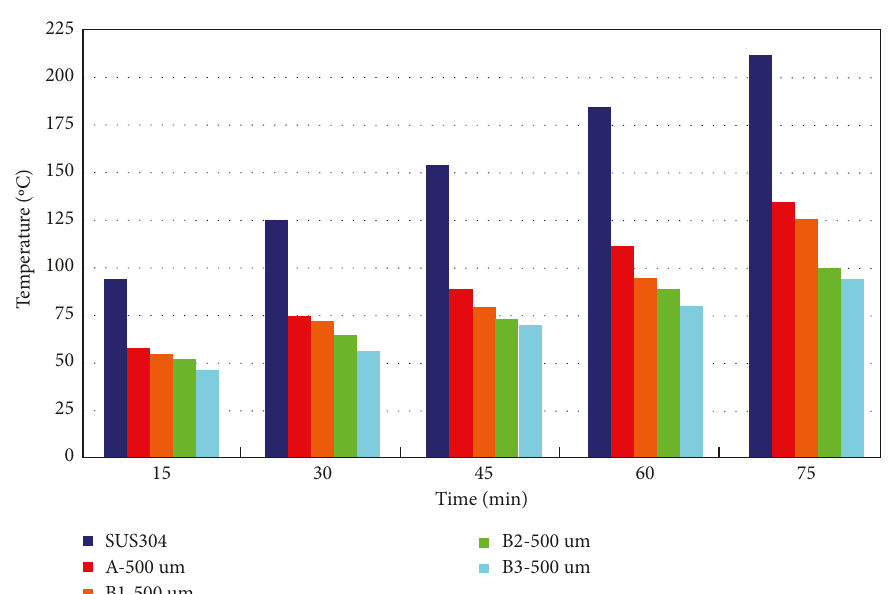
Figure 6: The temperature change analysis diagram of 500 μ m A and